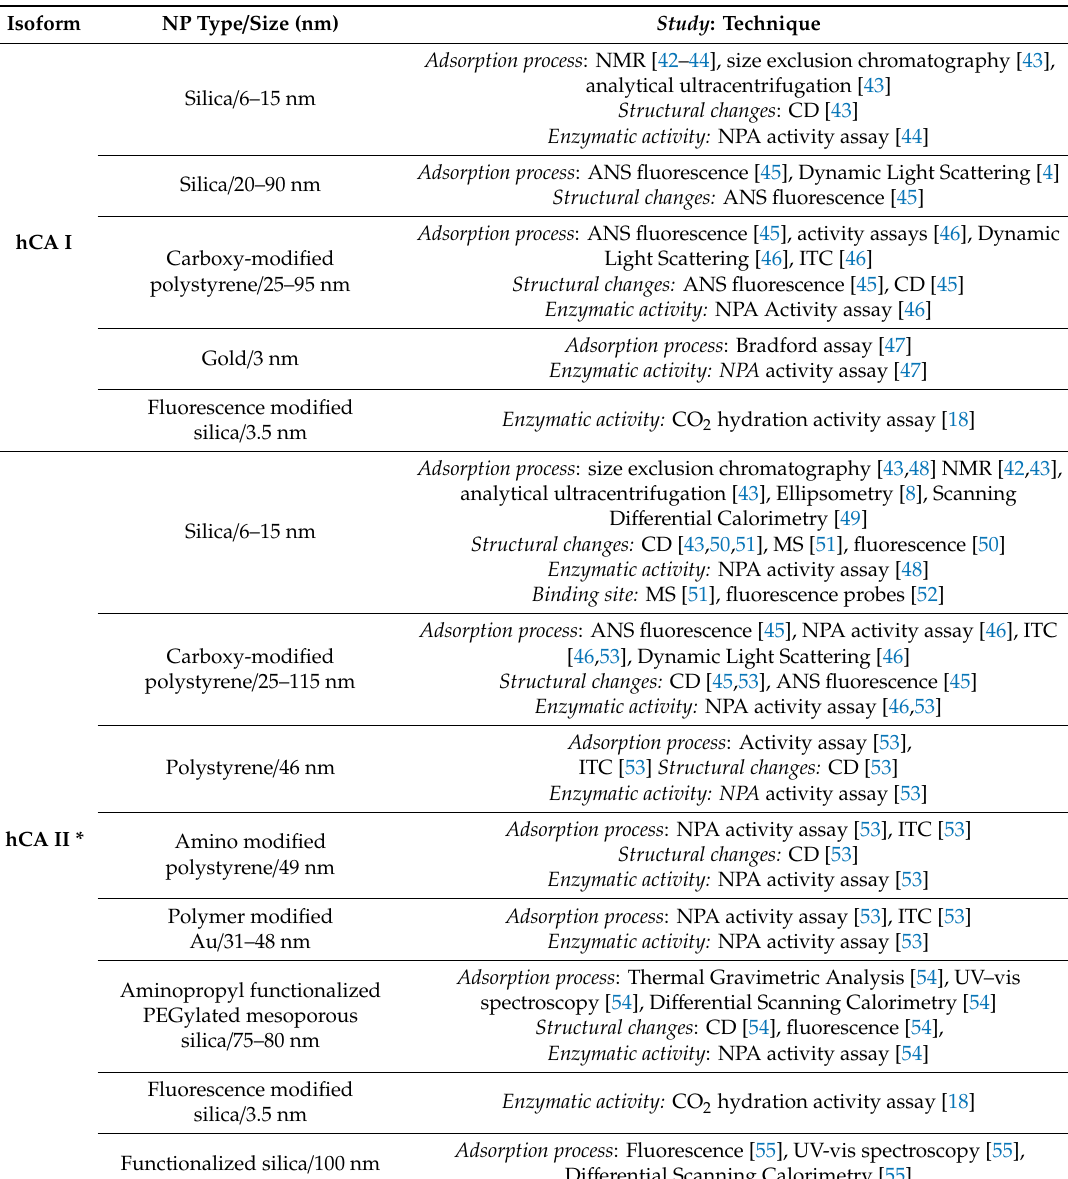
Table 1. Type of nanoparticles and techniques used to study a particular aspect in the interaction between hCA I and hCA II with nanoparticles